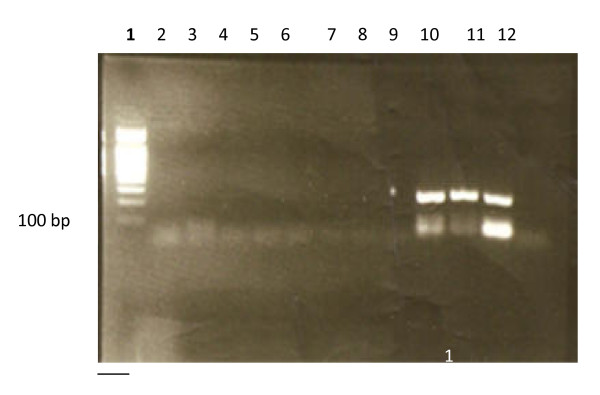
EB-stained gel electrophoresis of HHV-6-DNA PCR product showing positive lanes (10-12) and negative lanes (2-9). 100 bp ladder lane (1). N.B. positive signals are 249 bp., Lane 2 is negative control (water). Lane 12 is positive control